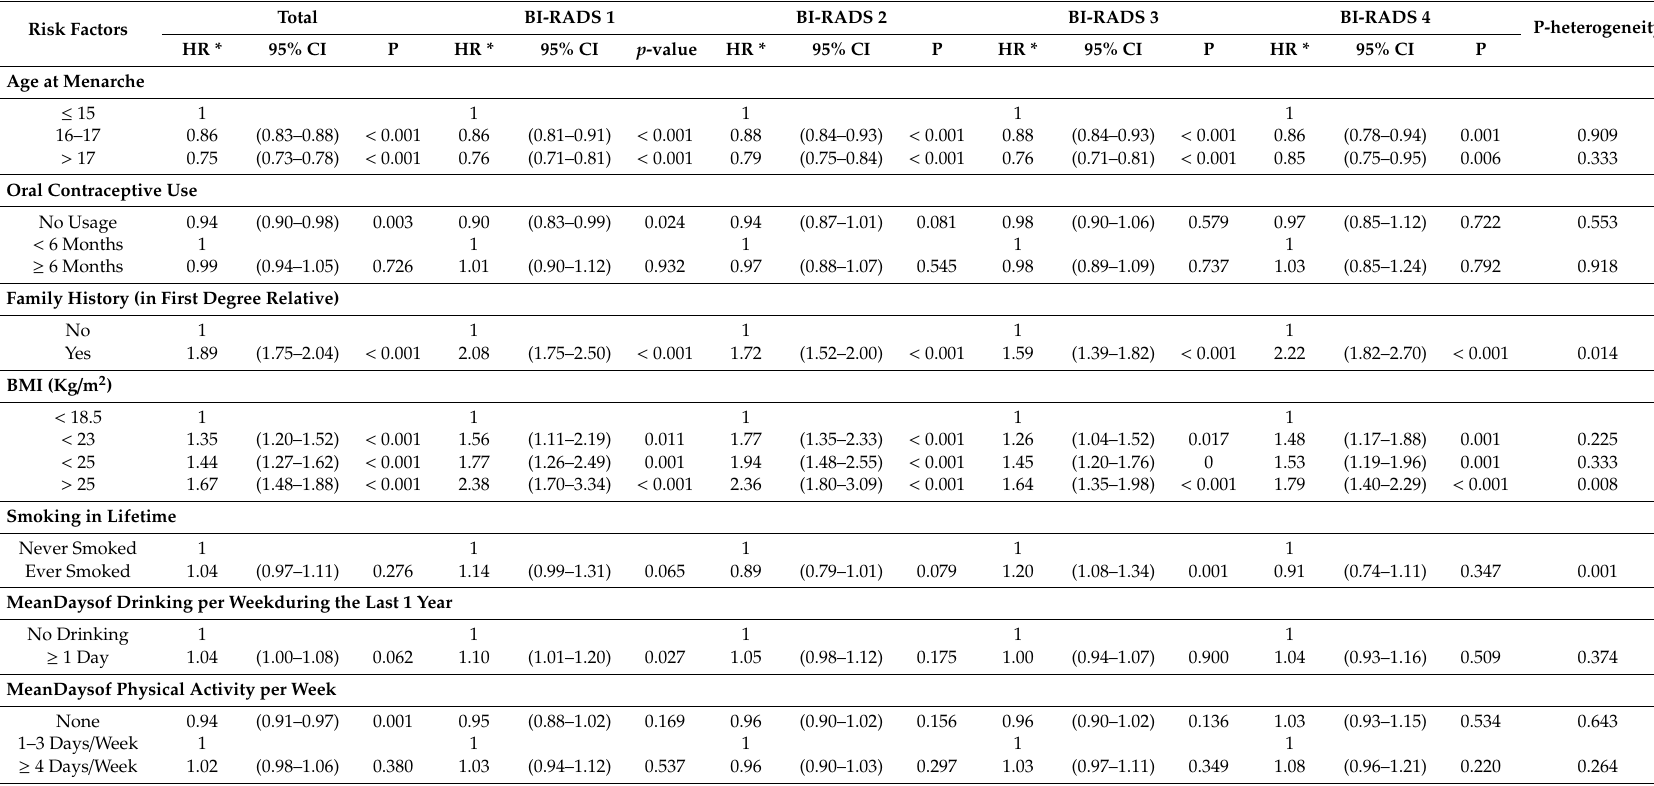
Table 4. Association between known risk factors of breast cancer and breast cancer development by breast density in postmenopausal